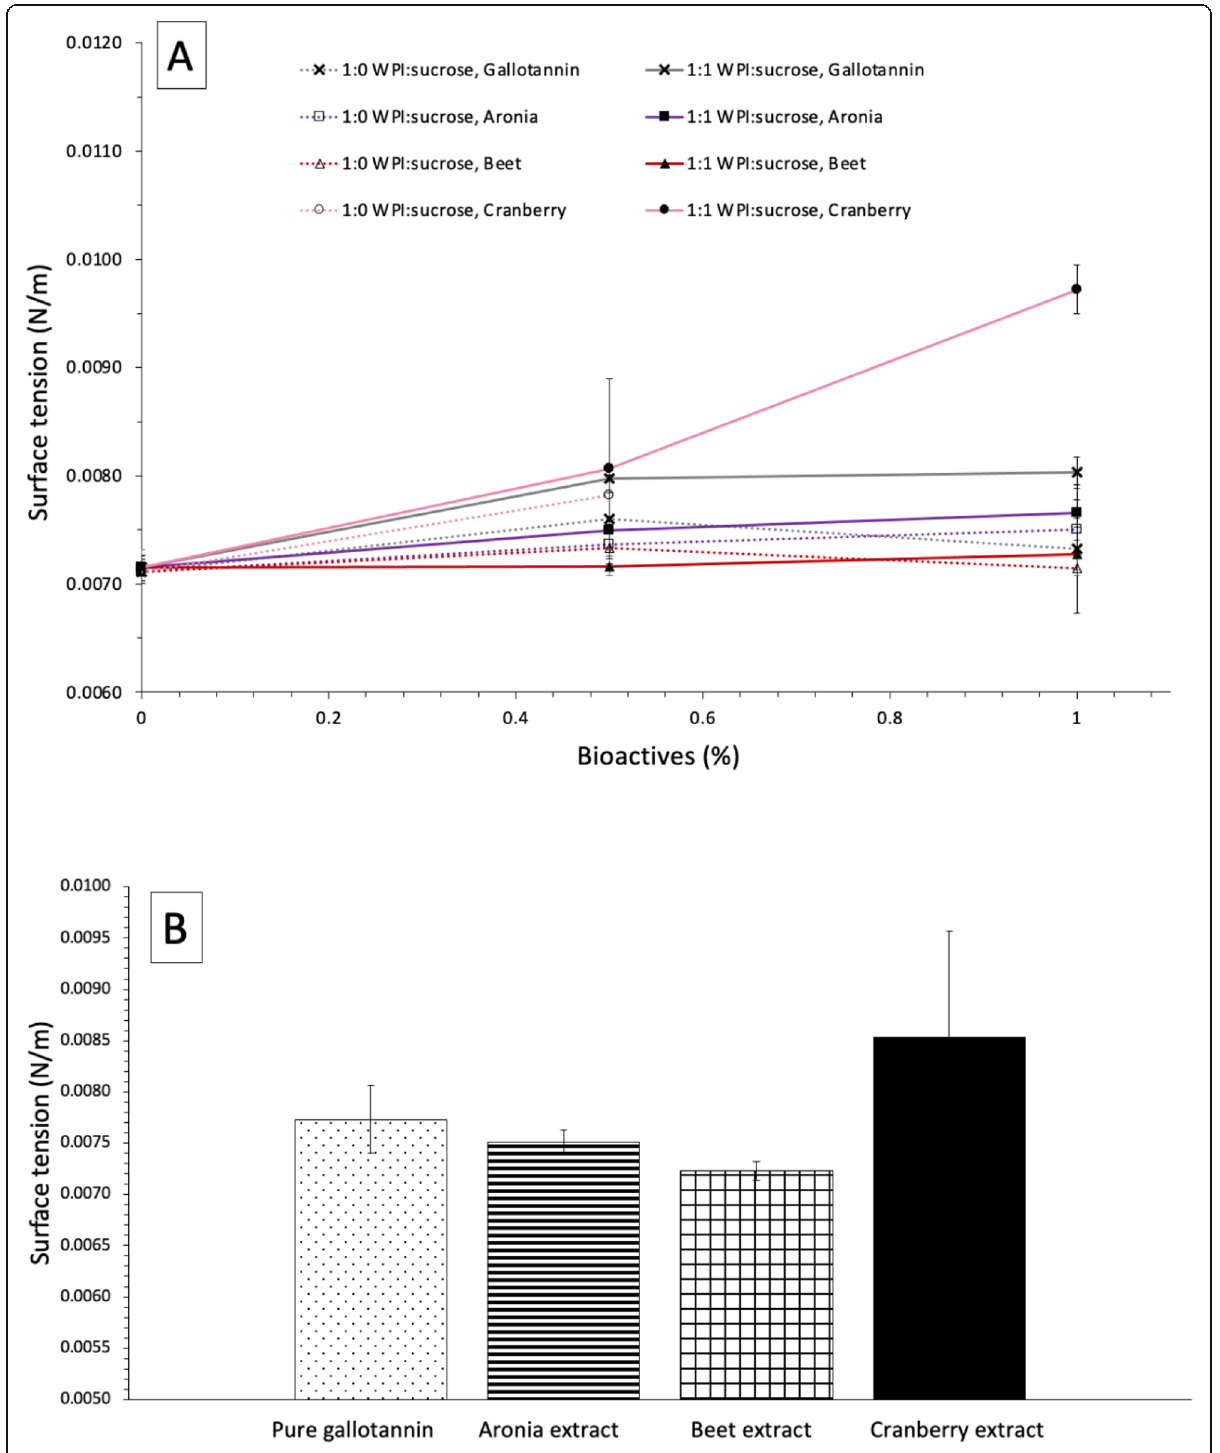
Fig. 1 Effect of bioactives content (%) A on the surface tensions (N/m) of dispersions at 25 °C ( n = 9); the effect of bioactives source B on the average surface tensions of all dispersions formulated with pure gallotannin, Aronia berry, beet, and cranberry extracts, respectively, at 25 °C; ( n = 12 for gallotannin, Aronia, and beet dispersions, n = 9 for cranberry dispersions). Lines are for guiding purposes only